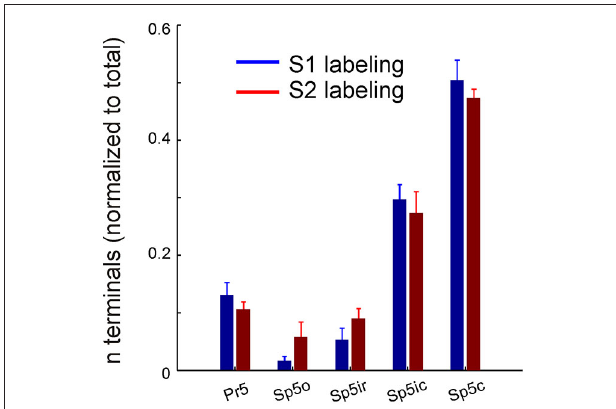
FIGURE 3 | Corticofugal terminal counts in the trigeminal sensory nuclei following dual tracer injections in S1 and S2. Bar graph showing the total number of labeled terminals resulting from anterograde tracer injections into S1 (blue) and S2 (red) whisker representations, normalized by the total number of terminals resulting from each injection, averaged across animals ( n = 3). Brackets indicate standard error of the mean.